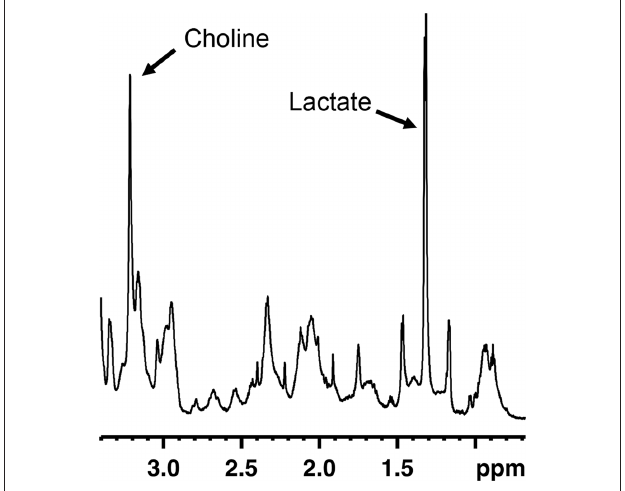
FIguRE 2 | Region of an MR spectrum generated from mouse fetal neural progenitor cells in culture. MRS reveals to complexity of metabolites found in these cells. Abundant molecules leading to strong signals, such as choline or lactate, can readily be